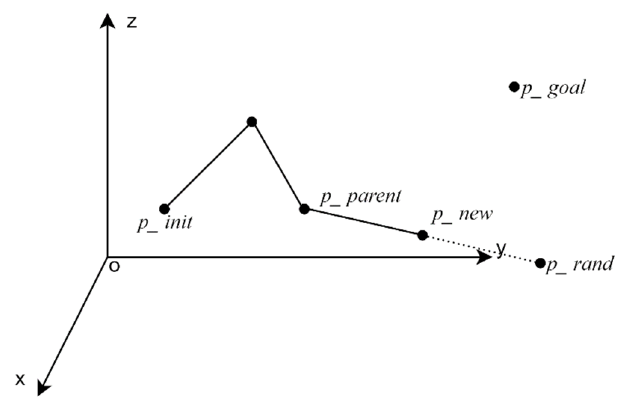
Figure 4. Tree expansion of the RRT in a 3D environment.